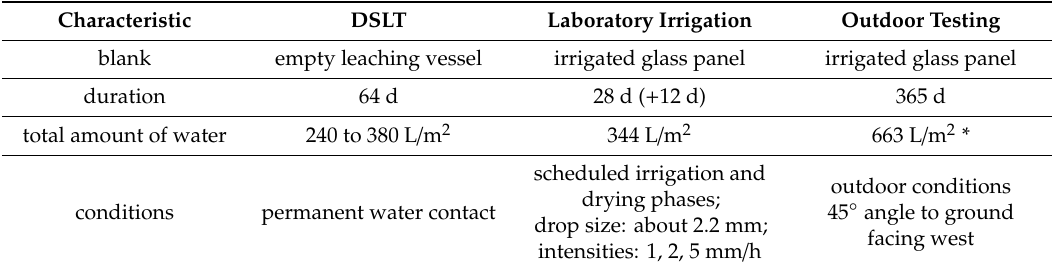
Table 6. Testing program